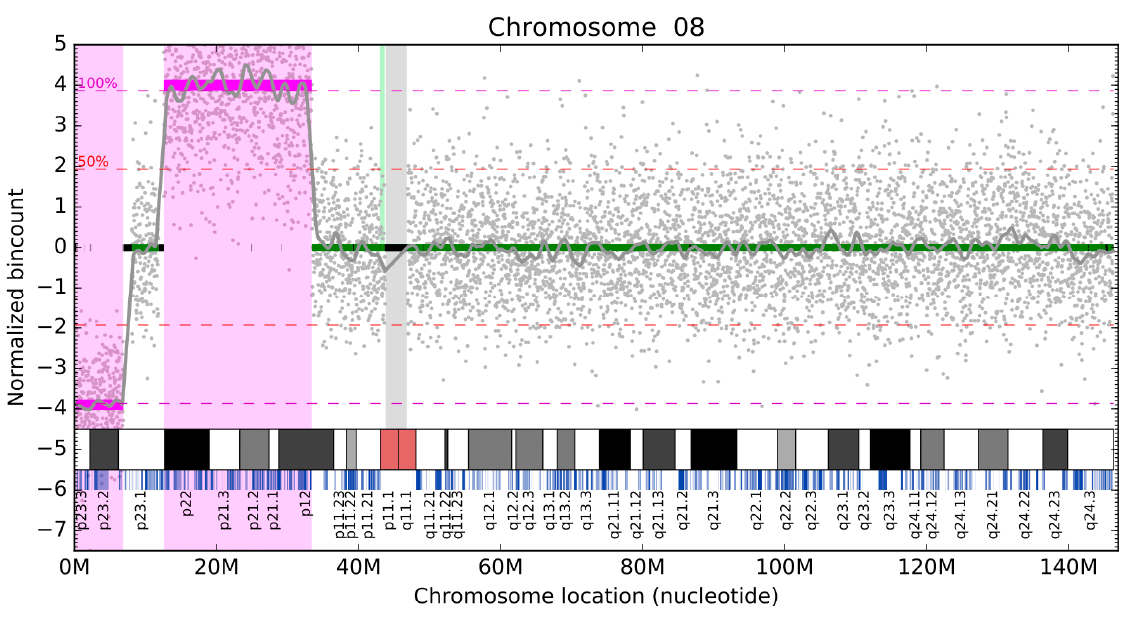
Figure 1. Visualization of the detected deviations on chromosome 8. Chromosome location is on the X-axis. Normalized bin count is on the Y-axis. Green lines represent normal bin count segments (normalized around zero), magenta lines visualize aberrations (one deletion at the start of the chromosome, one duplication on p22–p12). Filtered bins are depicted as black bars on the zero line on the Y-axis. The unmapped region around the centromere is visualized with the grey bar. Grey dots represent the normalized individual bin counts for each bin.